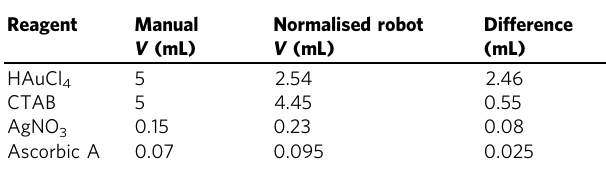
Table 1 Comparison of reagents used in optimal synthesis for space 2 (nanorod target) with the platform vs synthesis described in the literature (normalised to literature stock